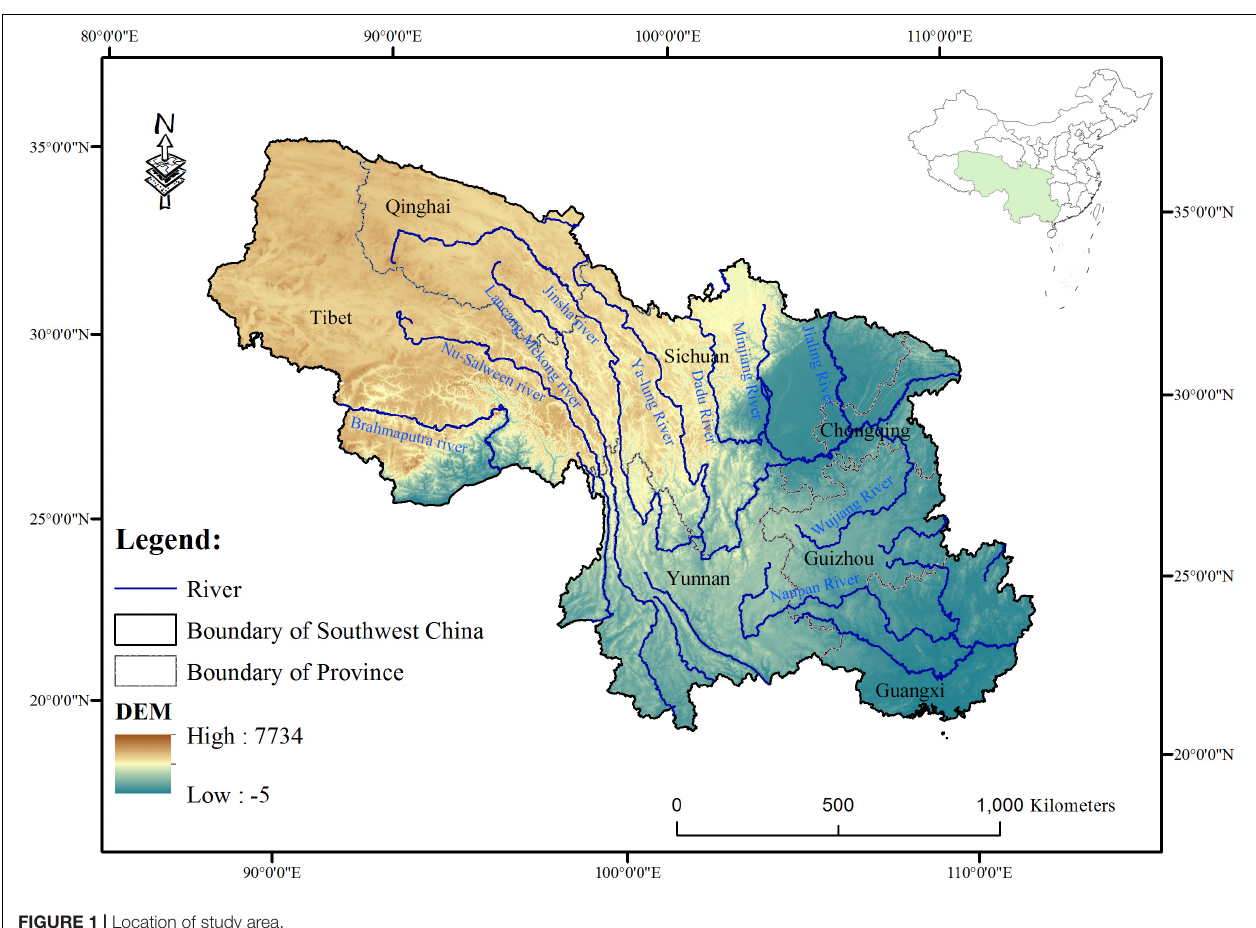
Table 2 ; Wang H. F. et al., 2018). The calculation formula of ecological risk is listed